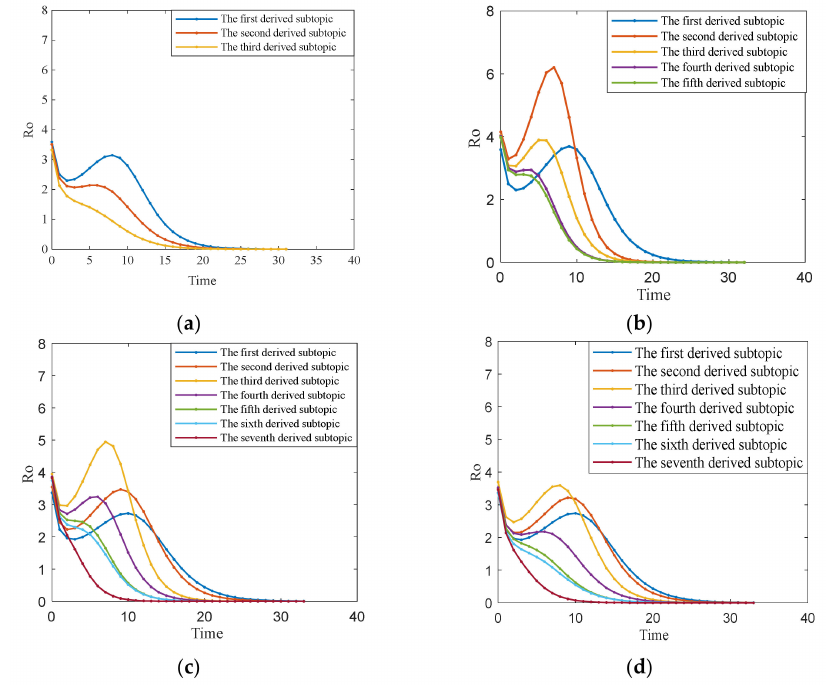
Figure 16. The change of R 0 under different environmental forces. ( a ) δ = 3. ( b ) δ = 5. ( c ) δ = 7. ( d ) δ = 9.